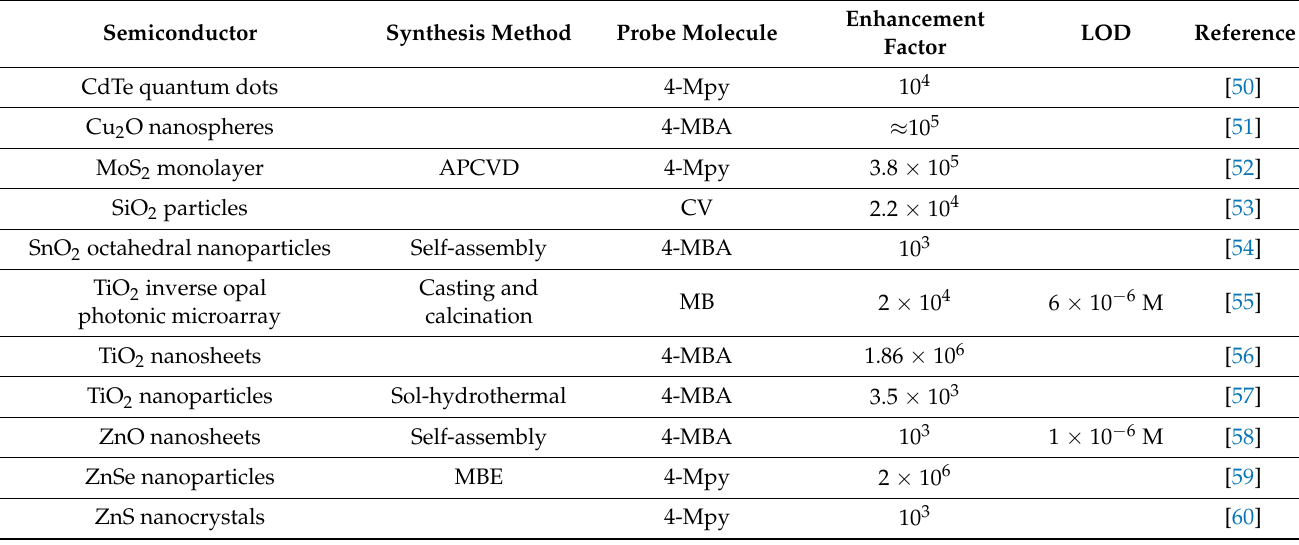
Table 1. Nanostructured semiconductors for SERS applications.